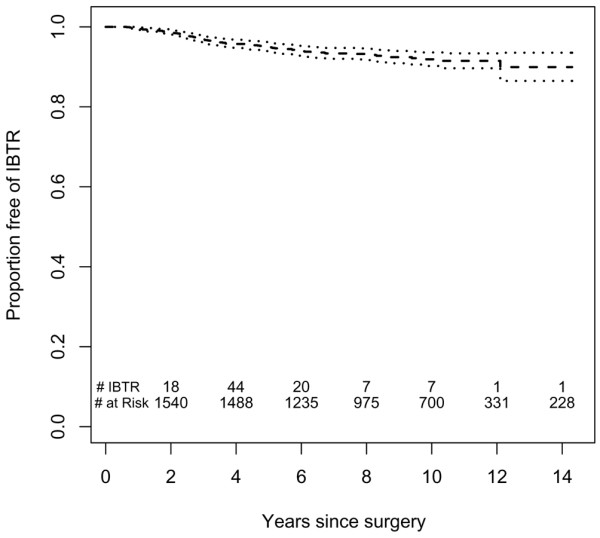
Kaplan–Meier estimate of ipsilateral breast tumour recurrence (IBTR).